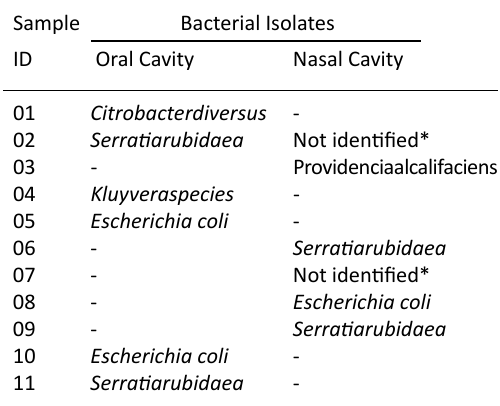
Table 4. Profiles of the bacterial isolates belonging to the Enterobacteriaceae family from swabs of the oral and nasal cavity from horses used for animal traction in the municipality of Umuarama, Parana, Brazil, 2016